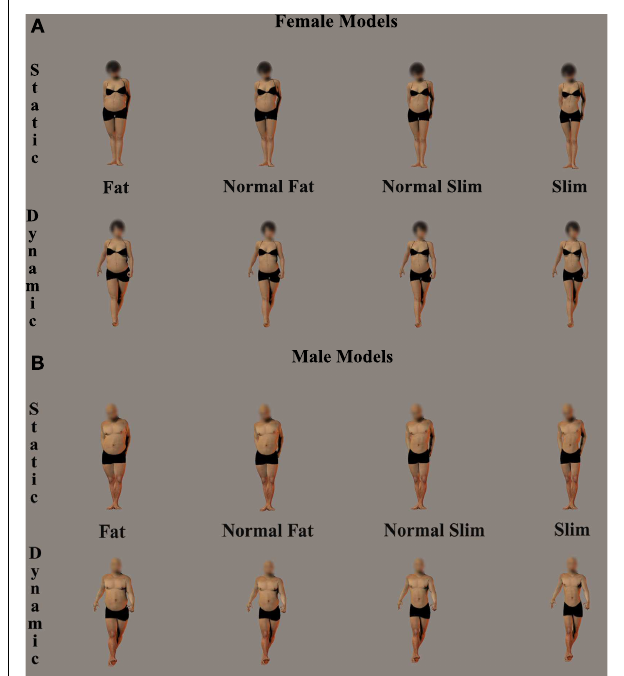
FIGURE 1 | Examples of female and male virtual models used in the study. The examples depict, from left to right, the body weight variation of either static or dynamic female (A) and male (B) models from extreme fat, normal fat, to normal slim, and extreme